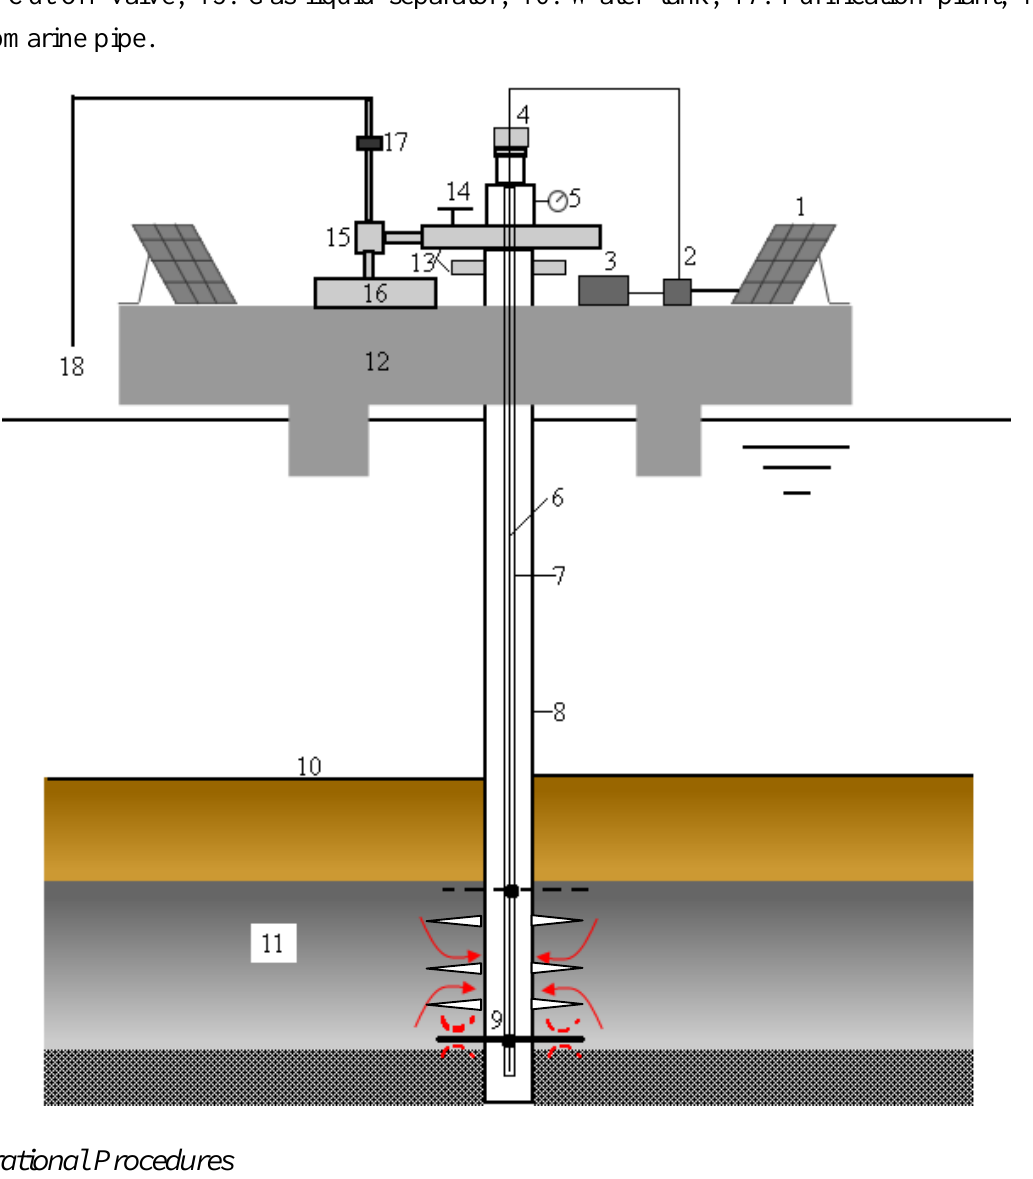
Figure 1. Sketch of a system for the utilization of solar energy for exploiting gas